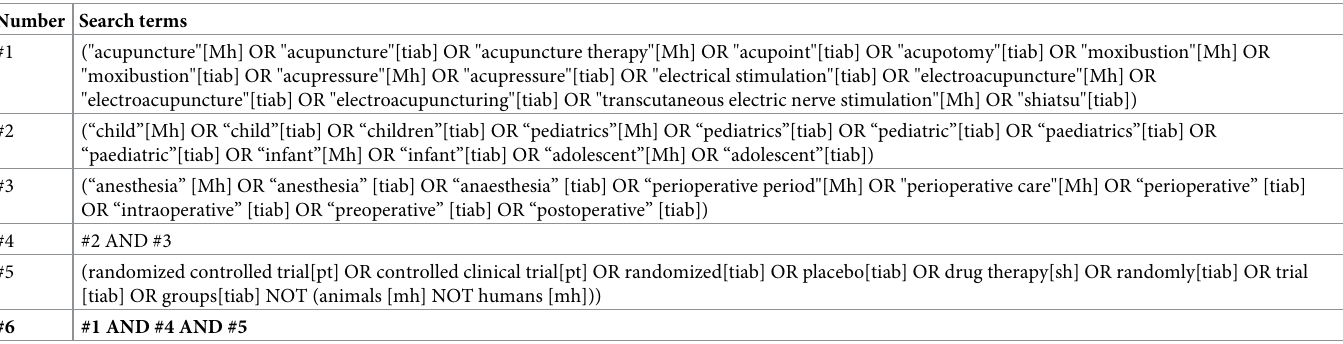
Table 1. Search strategy for